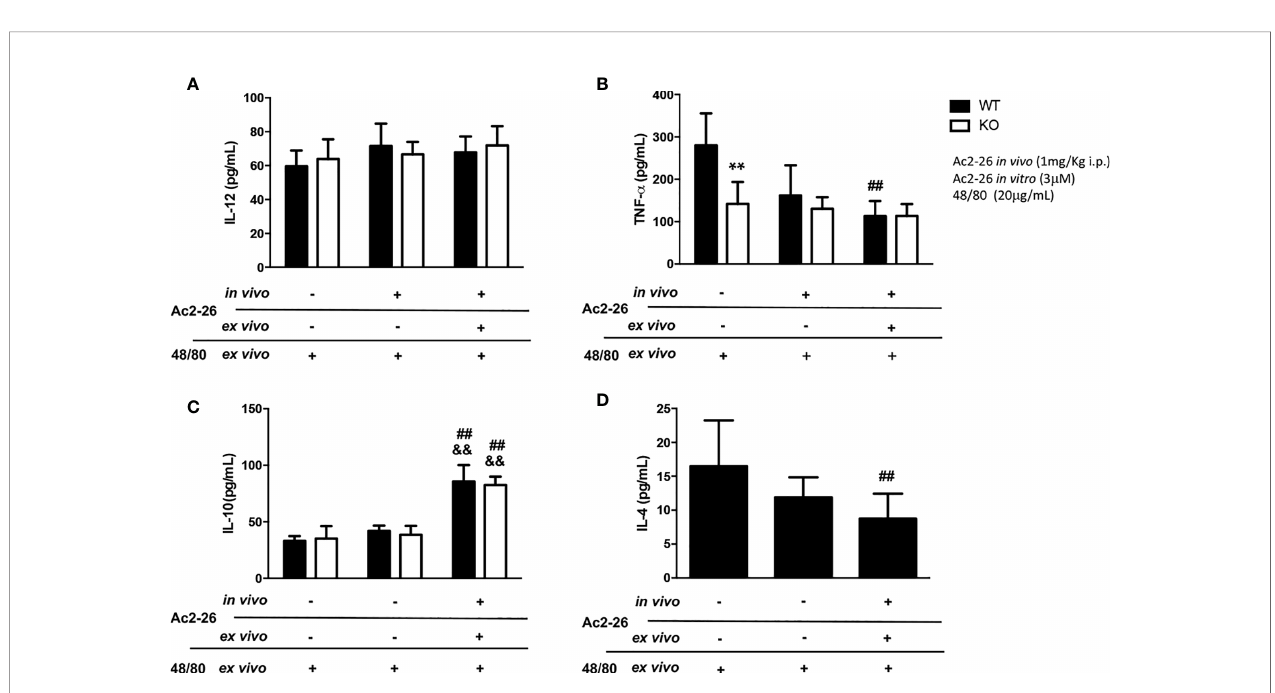
FIGURE 3 | Cytokine production by colon explants from C57BL/6 WT and C57BL/6 IL-4 KO mice treated in vivo with 1 mg/kg i.p. Ac 2-26 (+) or PBS (-). ELISA determined the concentration of IL-12 (A) , TNF- a (B) , IL-10 (C) and IL-4 (D) in explants stimulated for 24 h, with 20µg/mL compound 48/80 and with or without 3µM Ac2-26 treatment. Experiments were performed twice with n = 4 animals/group. Values of concentration in pg/mL are expressed as the mean ± S.D, n = 8. Data were analyzed using one-way ANOVA (post Tukey multiple-comparison test). **p <0.01 vs . respective WT group. ## p <0.01 vs . untreated in vivo and ex vivo (-/-) and && p <0.01 vs treated in vivo and not treated ex vivo